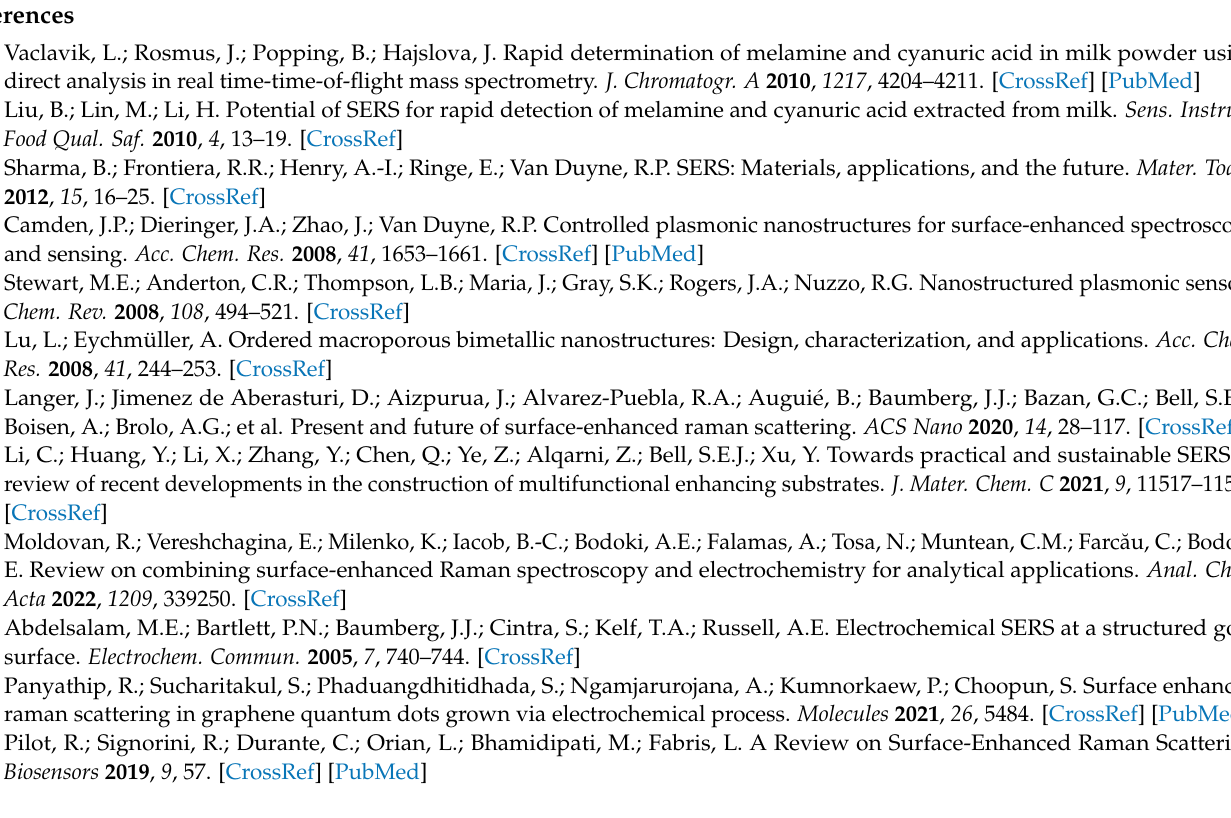
Figure S2: XRD diffraction pattern of CuO@RF@Ag nanowires was grown at the resorcinol weight of 16.37 mg and AgNO 3 concentration of 0.45 mM. Figure S3: The Raman spectrum of CuO@RF nanowires. Figure S4: The concentration dependence of R6G peak intensity at 1649 cm − 1 as a function of R6G concentrations ranging from 10 − 9 to 10 − 12 M. Figure S5: SERS spectrum of R6G at 10 − 13 M was obtained from CuO@RF@Ag nanowires. Table S1: Comparison of different methods for amoxicillin and 5-FU